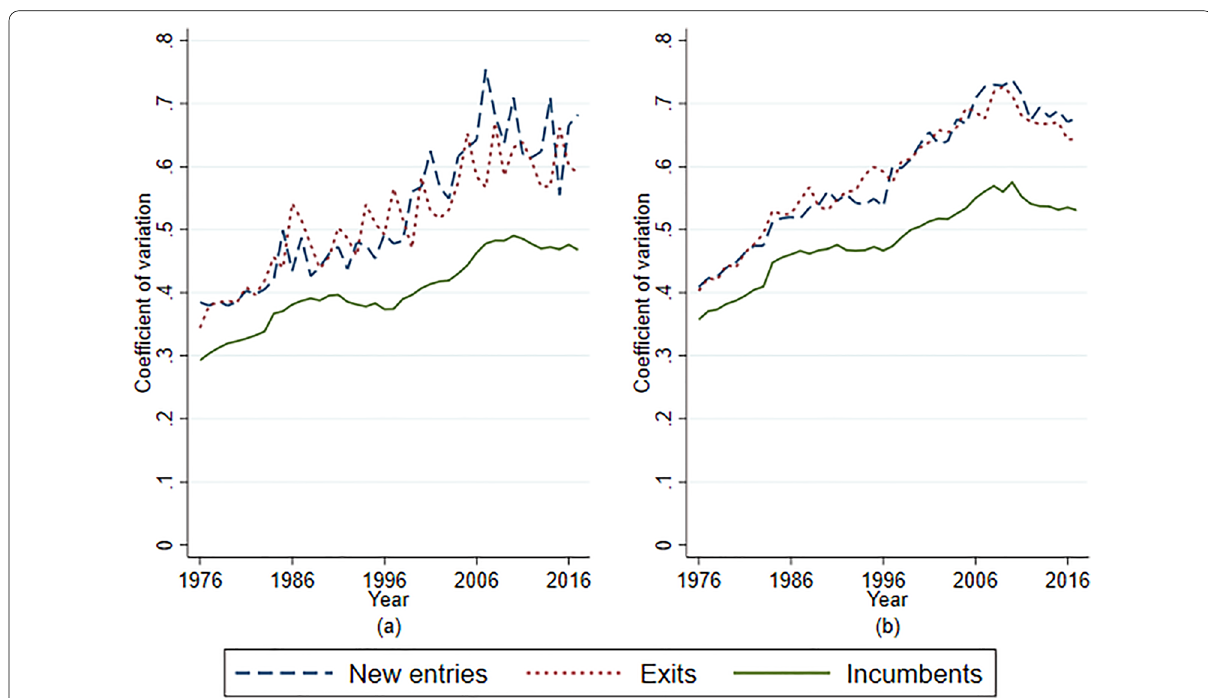
Fig. 5 Coefficient of variation of the average wage distribution by sector. a Depicts the manufacturing sector, b depicts the service